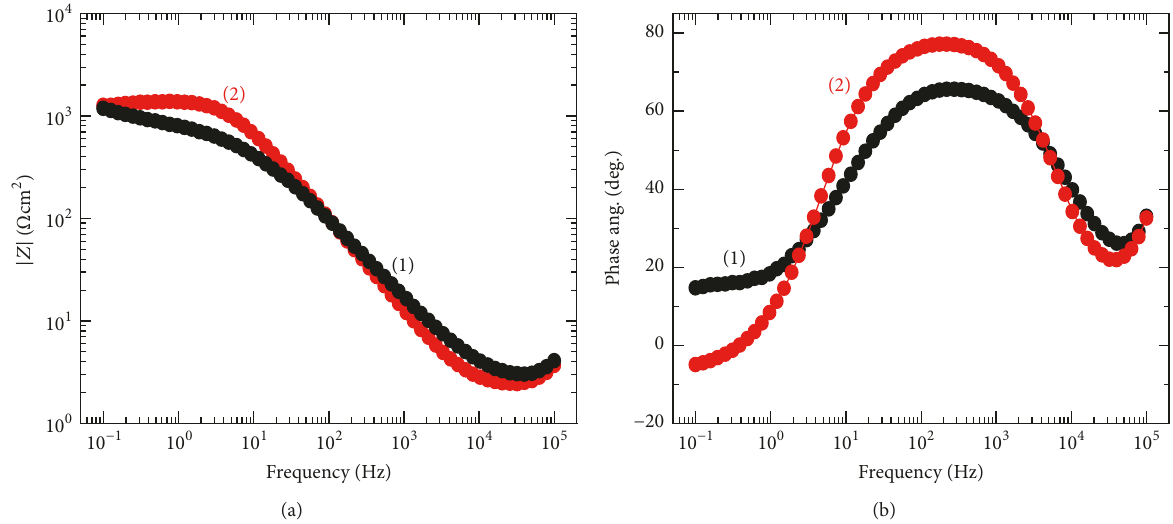
Figure 8: Typical Bode: (a) impedance of the interface, |𝑍| , and (b) phase angle plots obtained for iron-nickel alloy: ( 1 ) Fe-36% Ni and ( 2 ) Fe-45% Ni immersed in 1M HCl